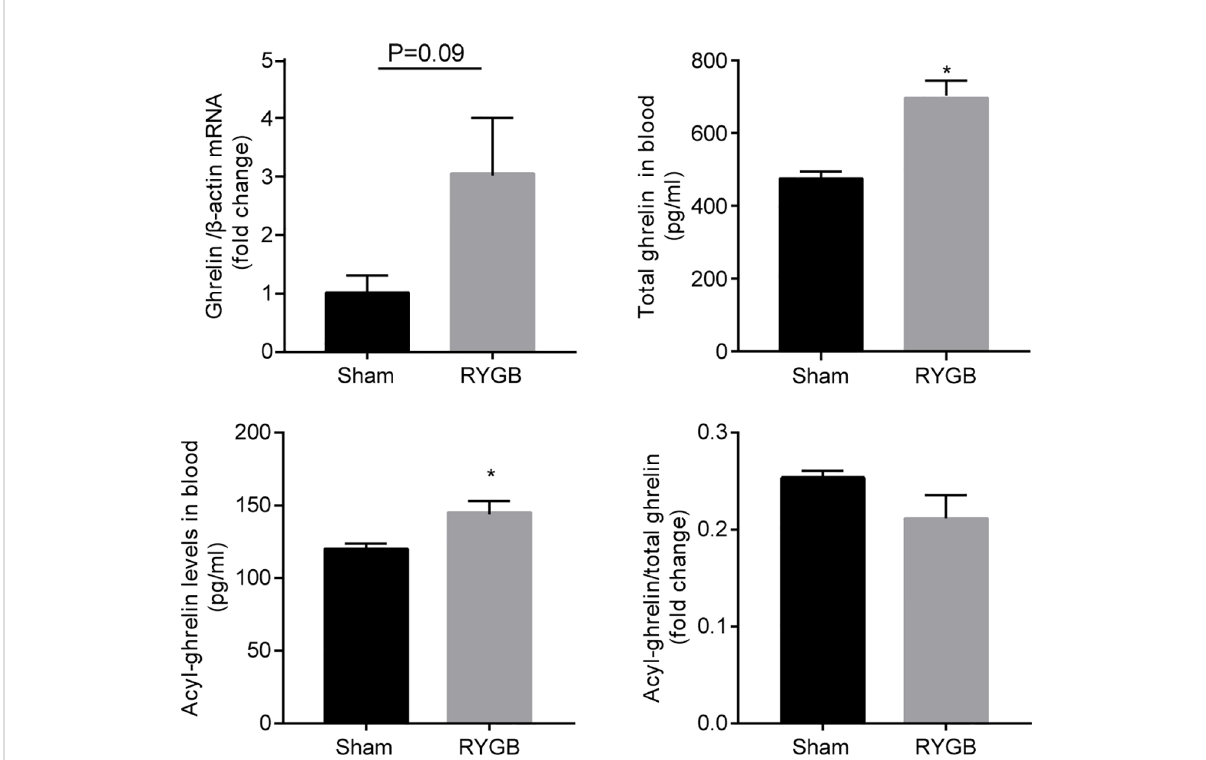
FIGURE 1 Increment of ghrelin after RYGB C57BL/6J mice were fed with high fat diet (HFD) for 12 weeks prior to and 3 weeks after Roux-en-Y gastric bypass surgery (RYGB). mRNA levels of gastric Ghrelin , and plasma total ghrelin and acyl-ghrelin were measured and the ratio of acyl-ghrelin/ total ghrelin calculated. b -actin was used as internal control. Data was presented as mean ± SEM. P values were determined by unpaired t test. *P<0.05 vs. sham. n=4 mice per